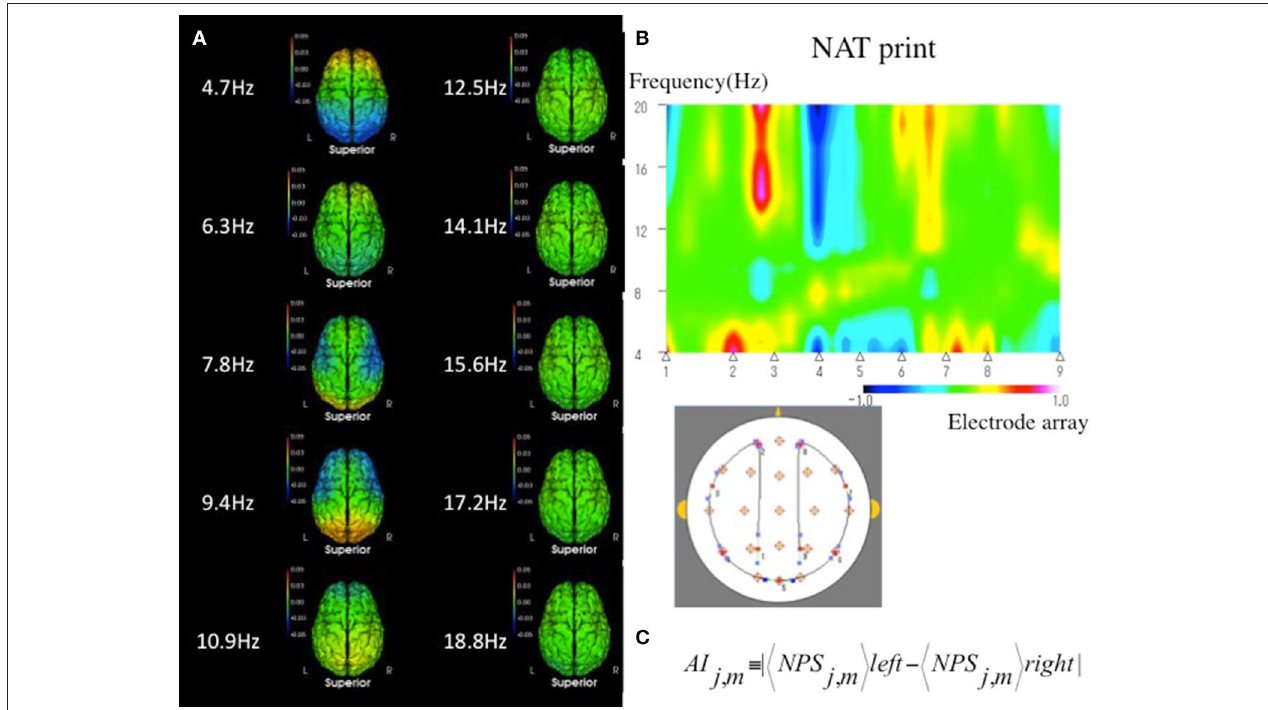
FIGURE 1 | (A) Mean sNAT map for a group of 55 VCI patients, viewed from above, for 10 frequency components from 4.7 to 18.8Hz, which are represented by 210-dimensional NAT spaces. Green indicates average spectrum intensities. Red and blue indicate hyperspectrum intensities and hypospectrum intensities, respectively. L, left; R, right. (B) In a qualitative method, NAT print is useful to show geometric symmetrically patterns of EEG on multidimensional NAT spaces at a glance. An example of NAT print symmetrically rearranged at the center of the Oz in a VCI patient. A VCI subject has a tendency to show an asymmetrical pattern in NAT print rather than a normal subject. Electrode array as above 1, 2, 3, 4, 5, 6, 7, 8, and 9 corresponds to P3, Fp1; the middle between F7-T3, T5, Oz, T6; the middle between F8-T4, Fp2, and P4, respectively. Green indicates average spectrum intensity, and red and blue indicate hyperspectrum intensities and hypospectrum intensities, respectively. (C) In a quantitative method, interhemispheric asymmetry index (AI) can be measured between the following eight regions and ten frequency components of interest: Eight regions with j = 1–8 consists of frontal (Fp1-2, F3-4, F7-8), central (C3-4), temporal (T3-4, T5-6), parietal (P3-4), and occipital (O1-2) pairs, respectively. Ten frequency components with m = 3–12 consist of 4.7, 6.3, 7.8, 9.4 10.9, 12.5, 14.1, 15.6, 17.2, and 18.8Hz, respectively. NPS, Normalized Power